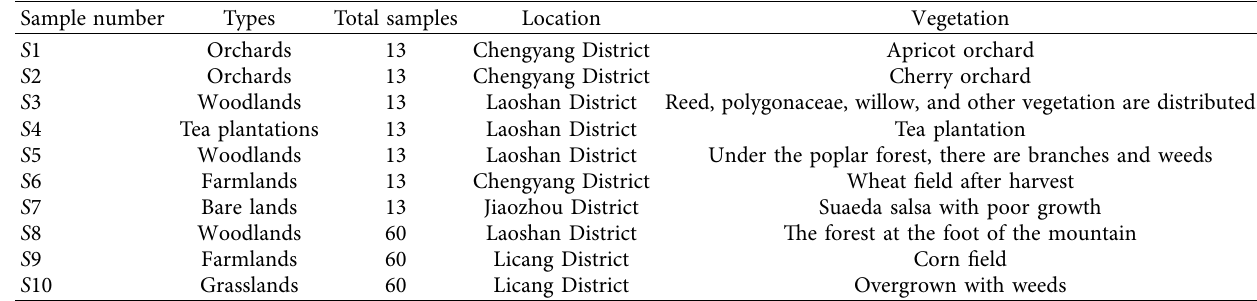
Table 1: The location and type of soil